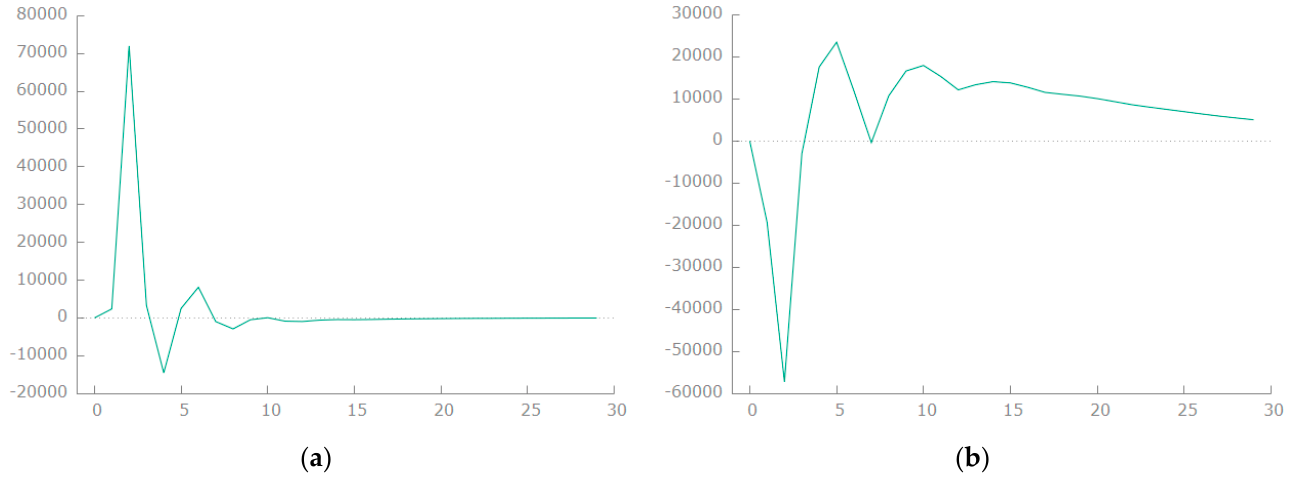
Figure 2. Examples of the response functions of the trading volume for Energa, Gda´nsk to the impulse: ( a ) average daily wind speed; ( b ) average daily relative humidity.